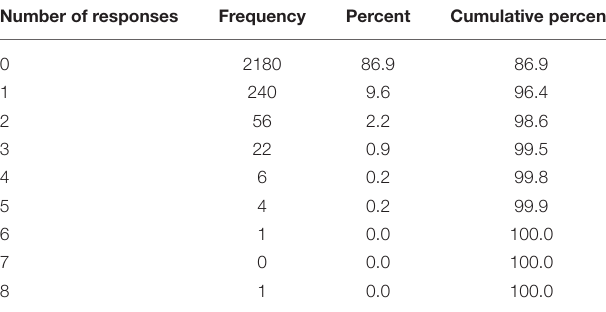
Figure 1 participants with one or more negative outcome derived significantly less benefit from psychedelic use, despite showing no differences in their assessment of pre-psychedelic symptom status [PHQ-9: t (2,508) = 6.55, p < 0.001, d = 0.39; GAD-7: t (2,508) = 6.27, p < 0.001, d = 0.37; HERO: t (2,508) = 5.76, p < 0.001, d =